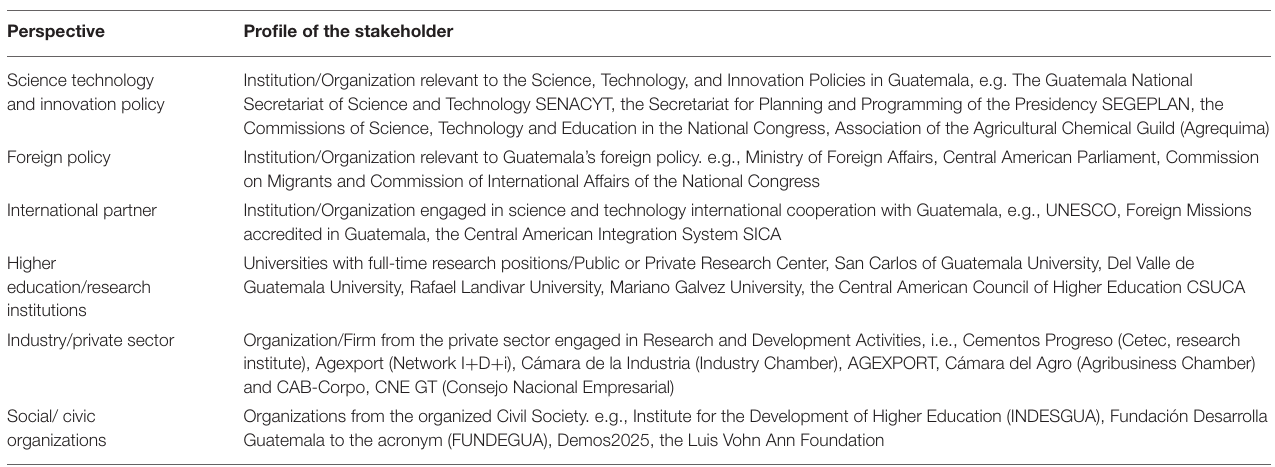
TABLE 2 | Perspectives and stakeholders relevant to the